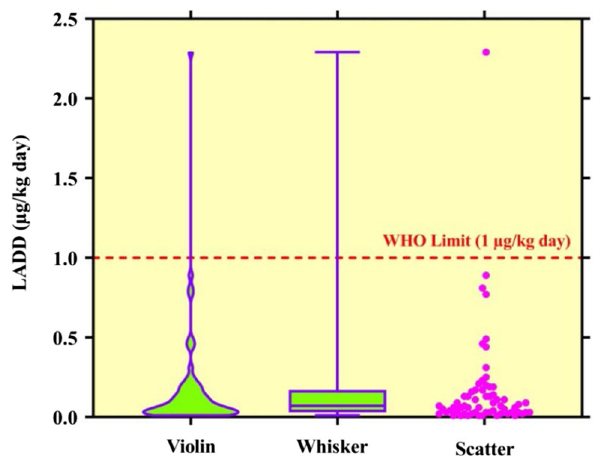
Fig. 13 Frequency distribution of LADD in adult males